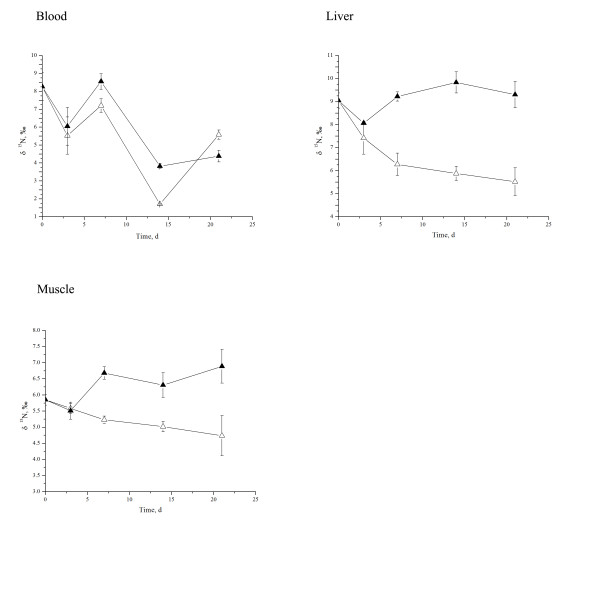
Nitrogen isotopic value change in Sprague–Dawley rat blood, liver, and muscle over time. Open triangles are treatment δ13C = −21.76‰, δ15N = 0.53‰ and filled triangles are treatment δ13C = −19.34‰, δ15N = 4.73‰. Data are shown as mean ± SE.